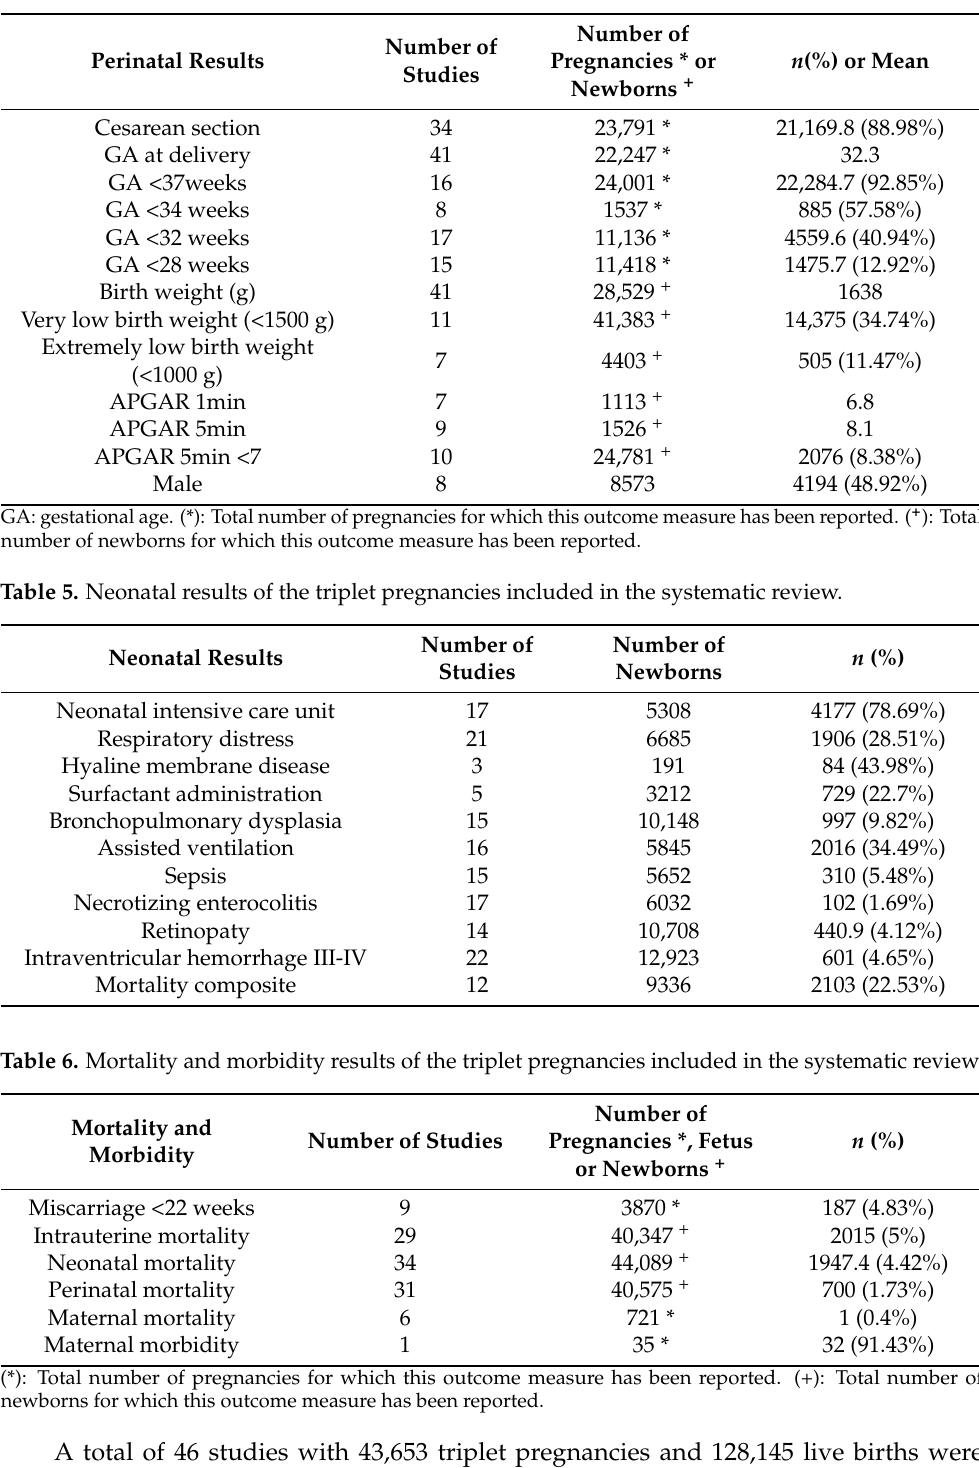
Table 4. Perinatal results of the triplet pregnancies included in the systematic review.